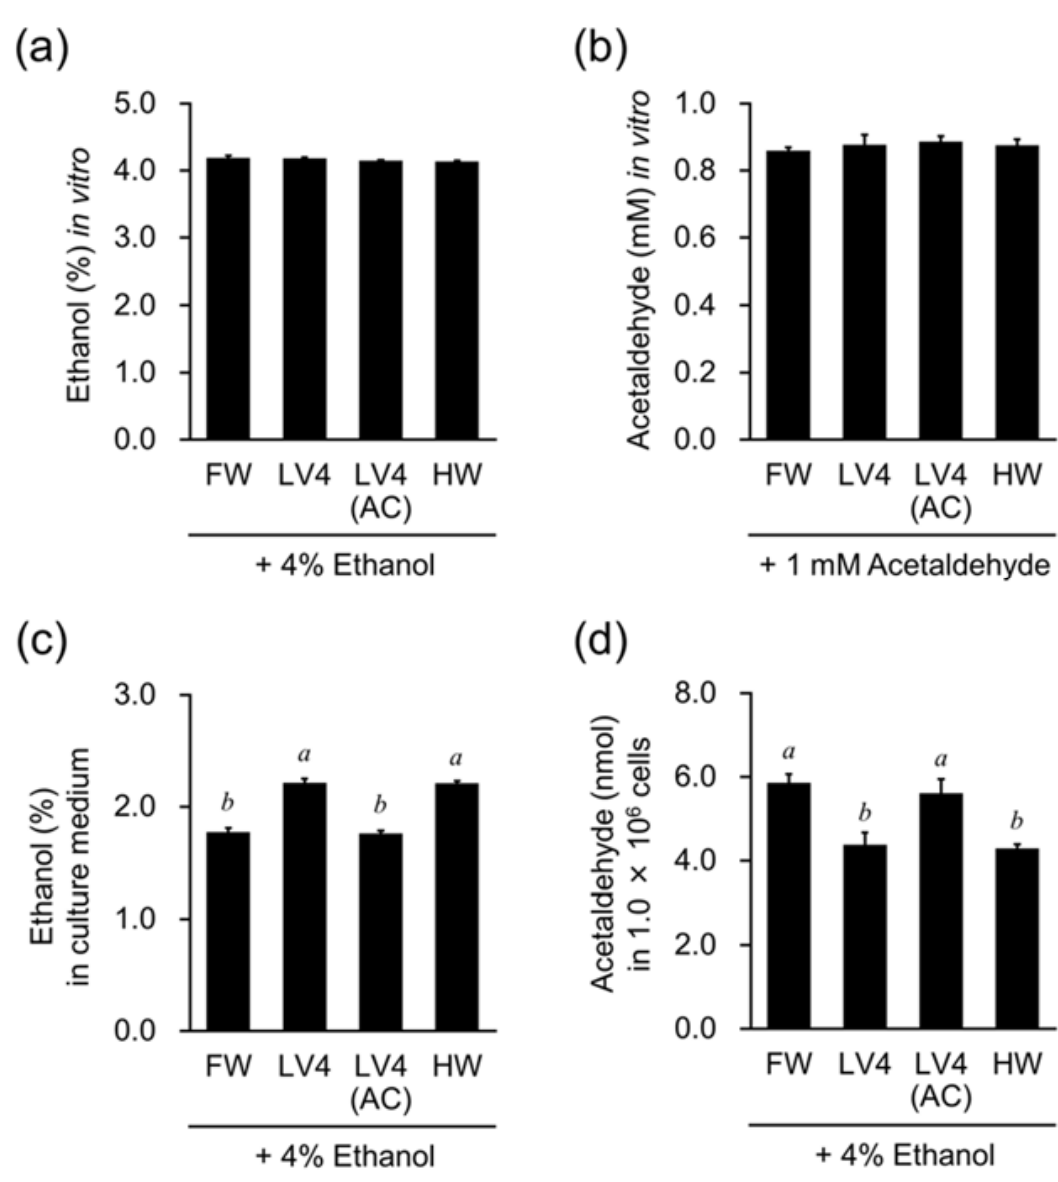
Figure 6. The comparison of the effect of EHW on ethanol and acetaldehyde metabolism in HepG2 cells. Concentration of ethanol ( a ) and acetaldehyde ( b ) in filtered water (FW), untreated EHW LV4 (LV4), autoclaved EHW [LV4 (AC)], or hydrogen rich water (HW) after 24 h. Ethanol concentration in cell culture supernatant ( c ), and concentration of acetaldehyde in cells ( d ) treated with FW, LV4, LV4 (AC), or HW mixed with 4% ethanol. The data represent the mean ± SEM ( n = 3). Data are analyzed by Tukey’s test after one-way ANOVA ( p < 0.05). Different letters above the bars indicate significant difference among treatments for each water with 4% ethanol.